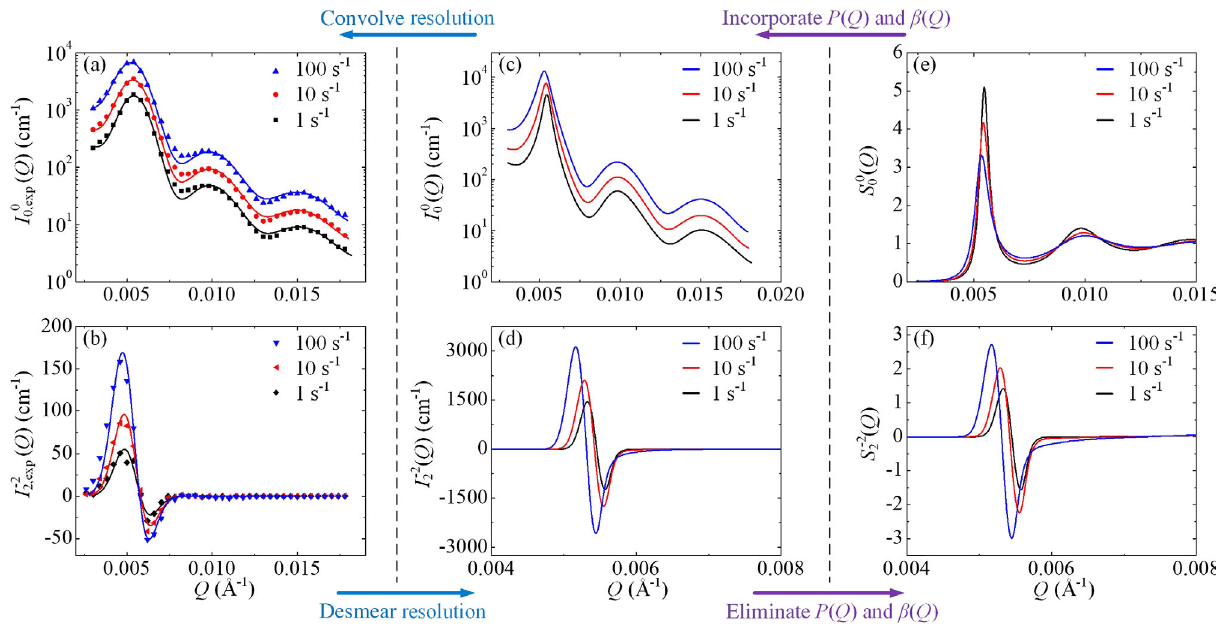
ð Q Þ and I − 2 2 ð Q Þ by eliminating the resolution effect. (e) and (f), ; exp ; exp